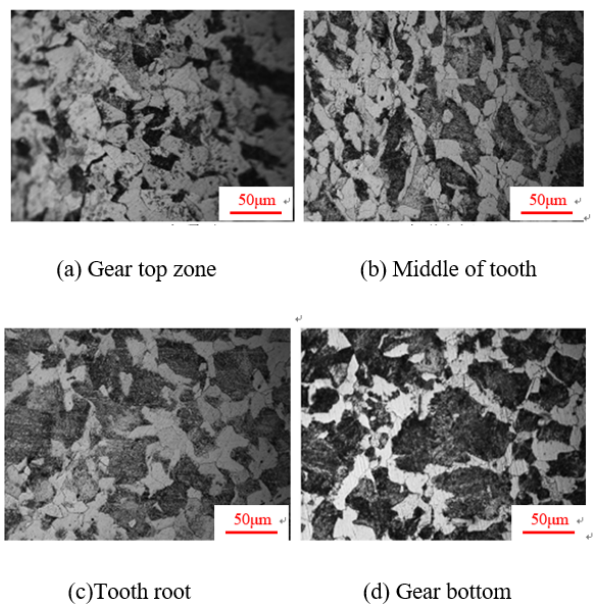
Figure 27. Microstructure of each area of gear (500X) (before op- timization).